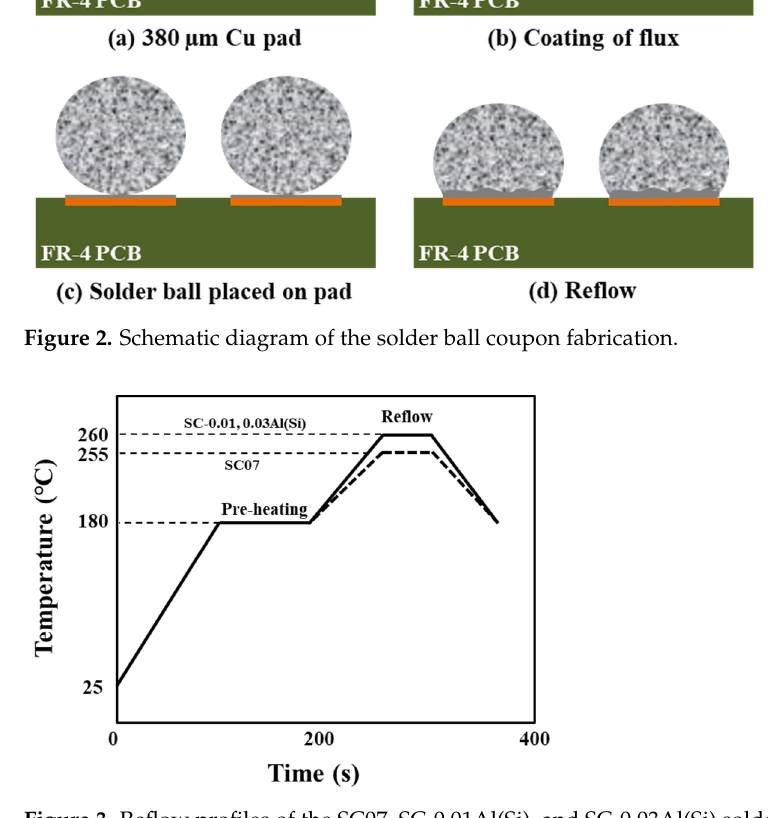
Figure 3. Reflow profiles of the SC07, SC-0.01Al(Si), and SC-0.03Al(Si) solders.